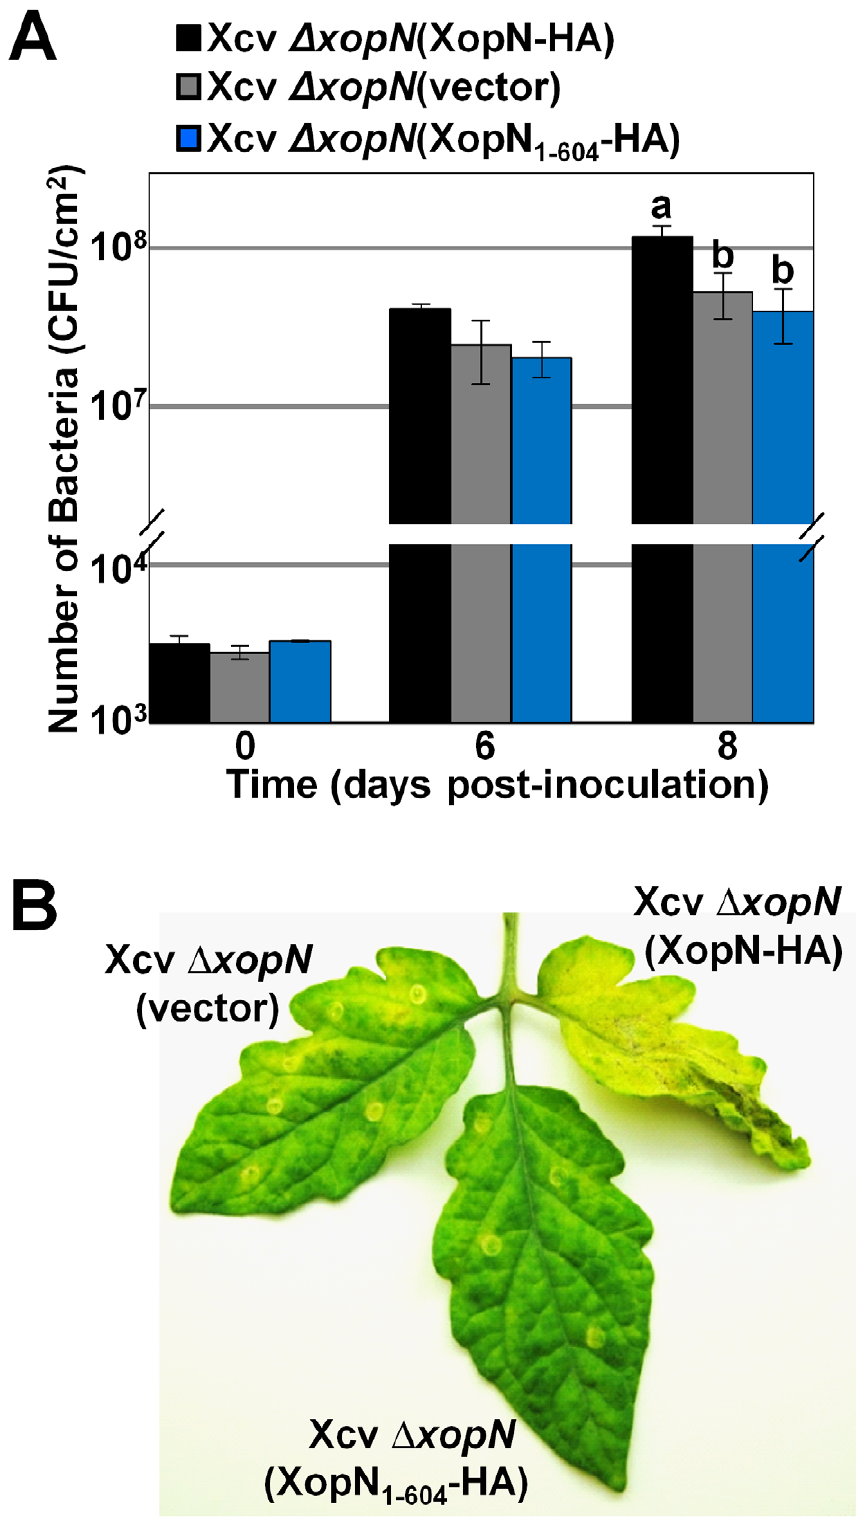
Figure 5. XopN residues 605–733 are important for TFT1 binding and contribute to XopN-dependent virulence in tomato. ( A ) Growth of Xcv D xopN (vector) (grey bars), Xcv D xopN (XopN 1–604 -HA) (blue bars), or Xcv D xopN (XopN-HA) (black bars) in susceptible tomato VF36 leaves. Leaves were inoculated with a 1 6 10 5 CFU/mL suspension of bacteria. Number of bacteria in each leaf was quantified at 0, 6 and 8 DPI. Data points represent mean CFU/cm 2 6 SD of three plants. Analysis was repeated at least three times. Vector=pVSP61. Different letters at day 8 indicate statistically significant (one-way analysis of variance and Tukey’s HSD test, P , 0.05) differences between the samples. ( B ) Phenotype of tomato leaves inoculated with strains described in ( A ). Leaves were photographed at 12 DPI. Similar phenotypes were observed in 3 independent experiments. doi:10.1371/journal.ppat.1002768.g005 PLoS Pathogens |